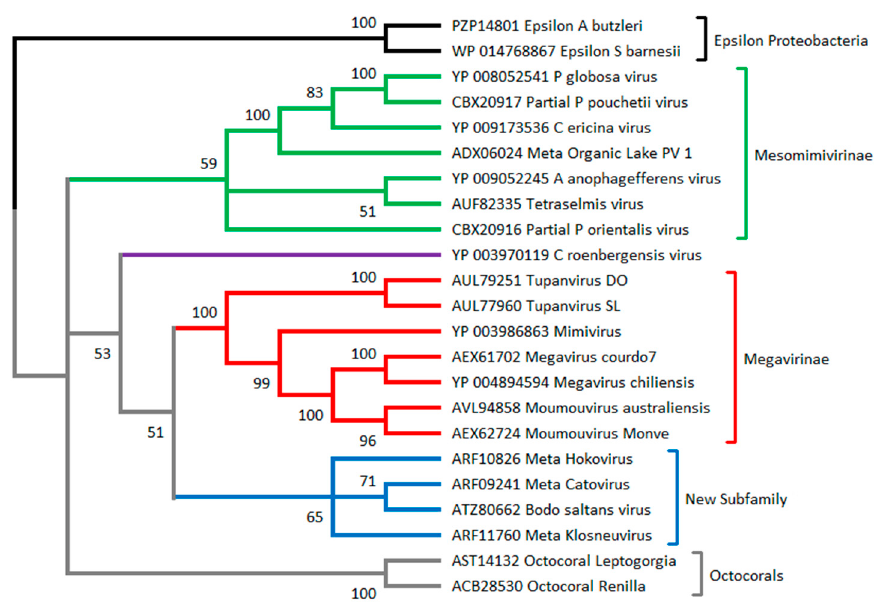
Figure 2. Phylogeny of Mimiviridae based on MutS7. MutS sequences from Epsilon proteobacteria (from the genera Arcobacter and Sulfurospirillum ) are used as the root, as they are most likely the source of the Mimiviridae MutS7 gene (MutS homologs are present throughout the epsilon division). The tree suggests with great confidence that the mitochondrial MutS present in octocorals (in grey) and that are present in all Mimiviridae have a common origin. The clustering of the Mimiviridae into several subfamilies is mostly consistent with that suggested by the DNA polymerase phylogeny (Figure 1). The algae-infecting Mimiviridae (in green) now appears monophyletic. This tree was produced from an alignment of 23 sequences (479 sites) using neighbor joining and the JTT substitution model. Bootstrap values are indicated on each branch. The computations were performed on the MAFFT online service [50]. NCBI accession numbers are given for each sequence. The prefix “Meta” indicates sequences from nonisolated viruses. The prefix “Partial” indicates sequences from amplicons.